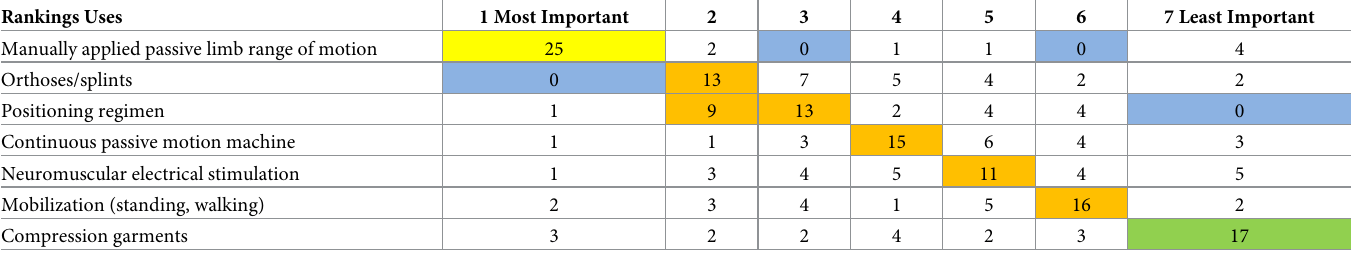
Table 3. Rankings awarded by respondents based on the importance of the use of passive range of motion techniques/modalities. Rankings